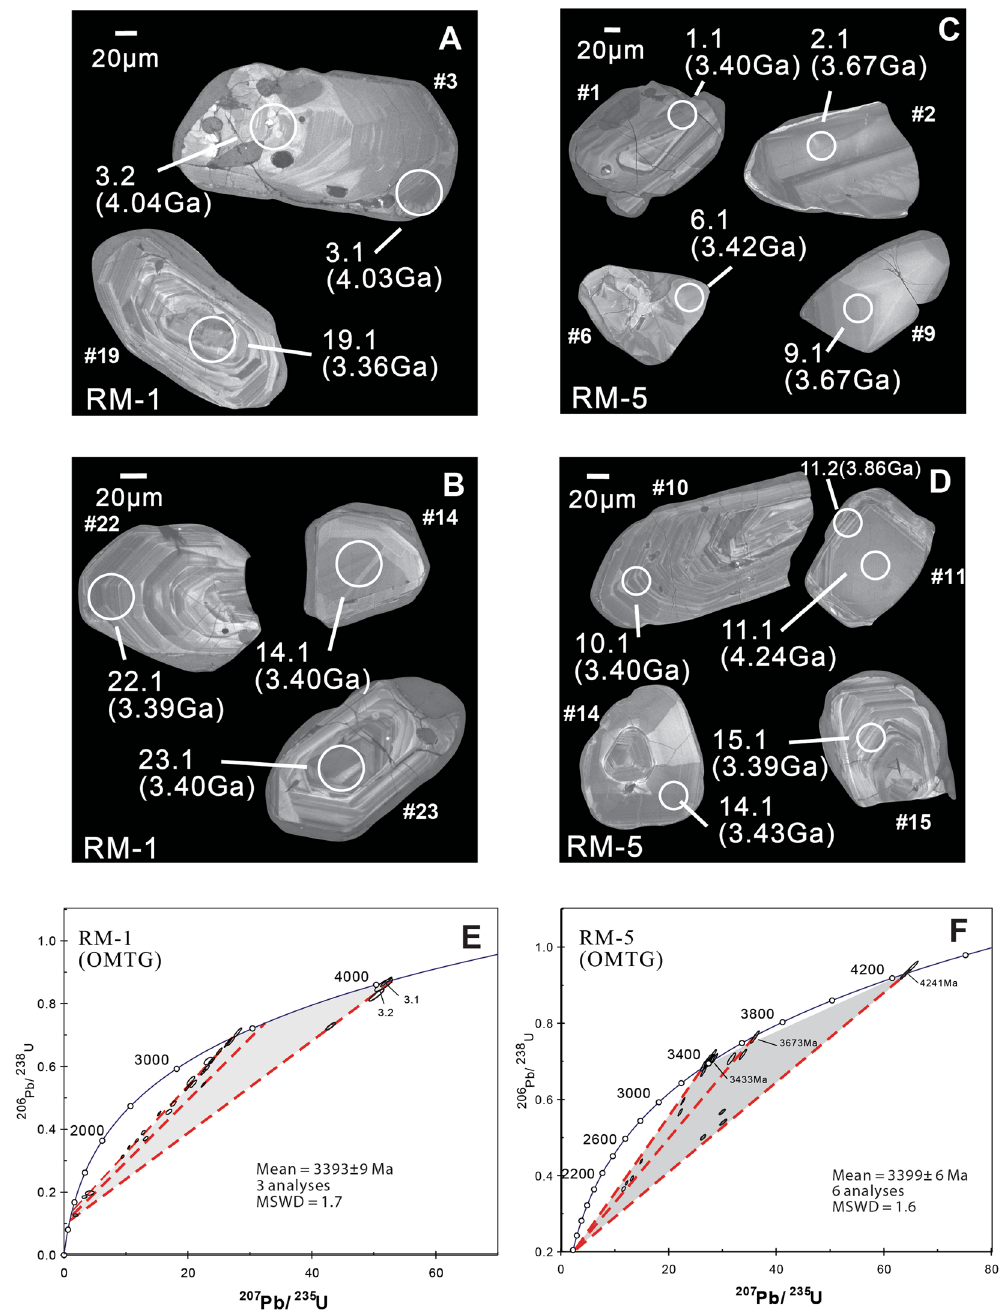
Figure 2. ( A , B ) Cathodoluminiscence (CL) image of zircons from OMTG sample RM-1, ( C , D ) from sample RM-5. Circles represent analyses spot positions with spot numbers and their ages in Ga. Grain numbers are shown beside each grain (e.g. #1). ( E , F ) U-Pb concordia plots for the zircons from samples RM-1 and RM-5 respectively (ages represent weighted mean of ages in Ma). Separate discordia lines were fitted through different age groups of zircons. Error ellipses are shown at 1 σ